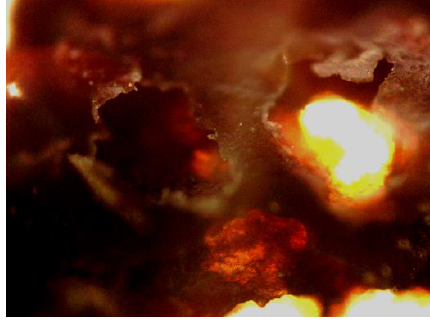
Figure 5. SEM images of floc at 100 magnifications.